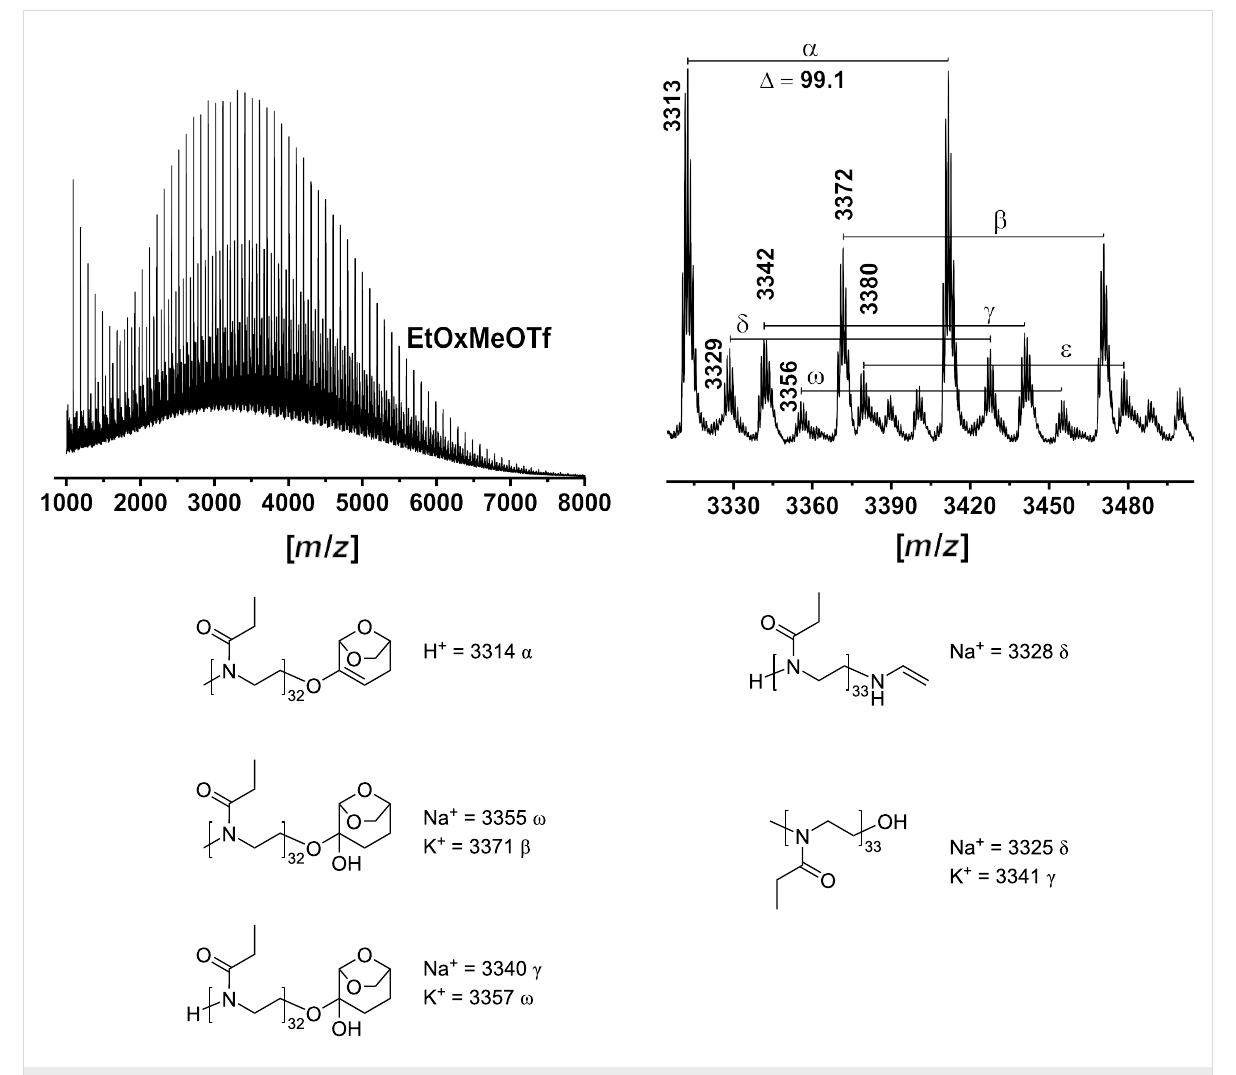
Figure 4: MALDI-TOF mass spectrometry analysis of the poly(2-ethyl-2-oxazoline) initiated with 2-ethyl-3-methyl-2-oxazolinium triflate in DLG at 90 °C.